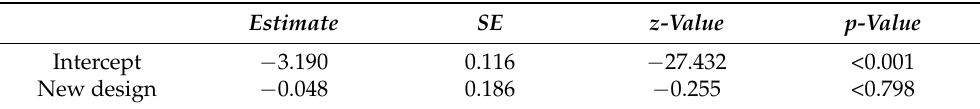
Table 1. Parameter estimation to compare mortality during confinement in a new container design and a control. Mortality during confinement.